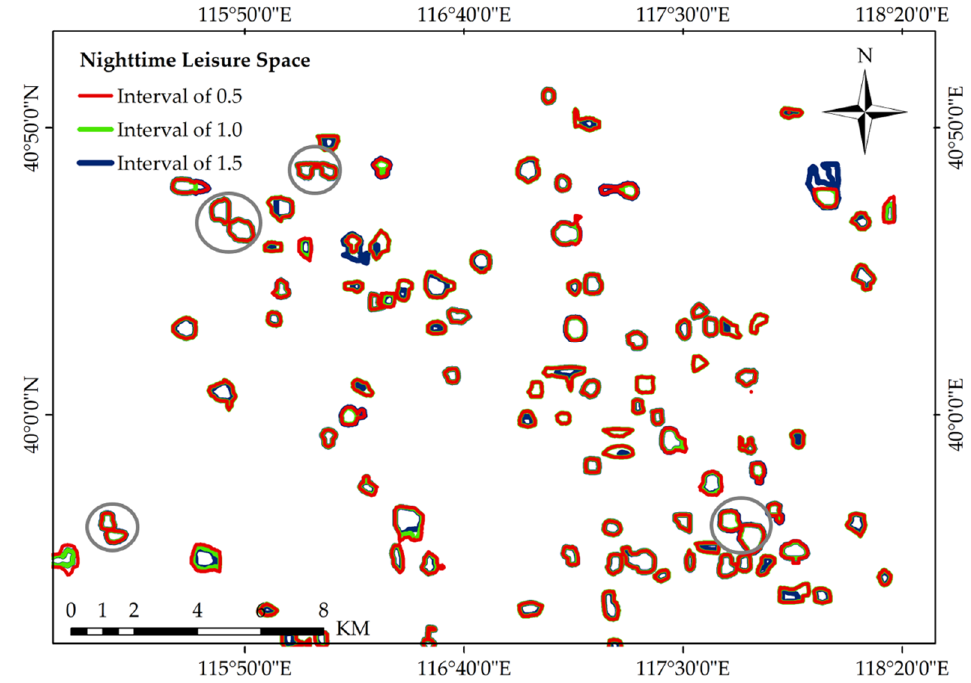
Figure 10. Sensitivity of the detected UNLS to the contour interval value. Table 7. Impact of the contour interval on the detection of UNLSs.